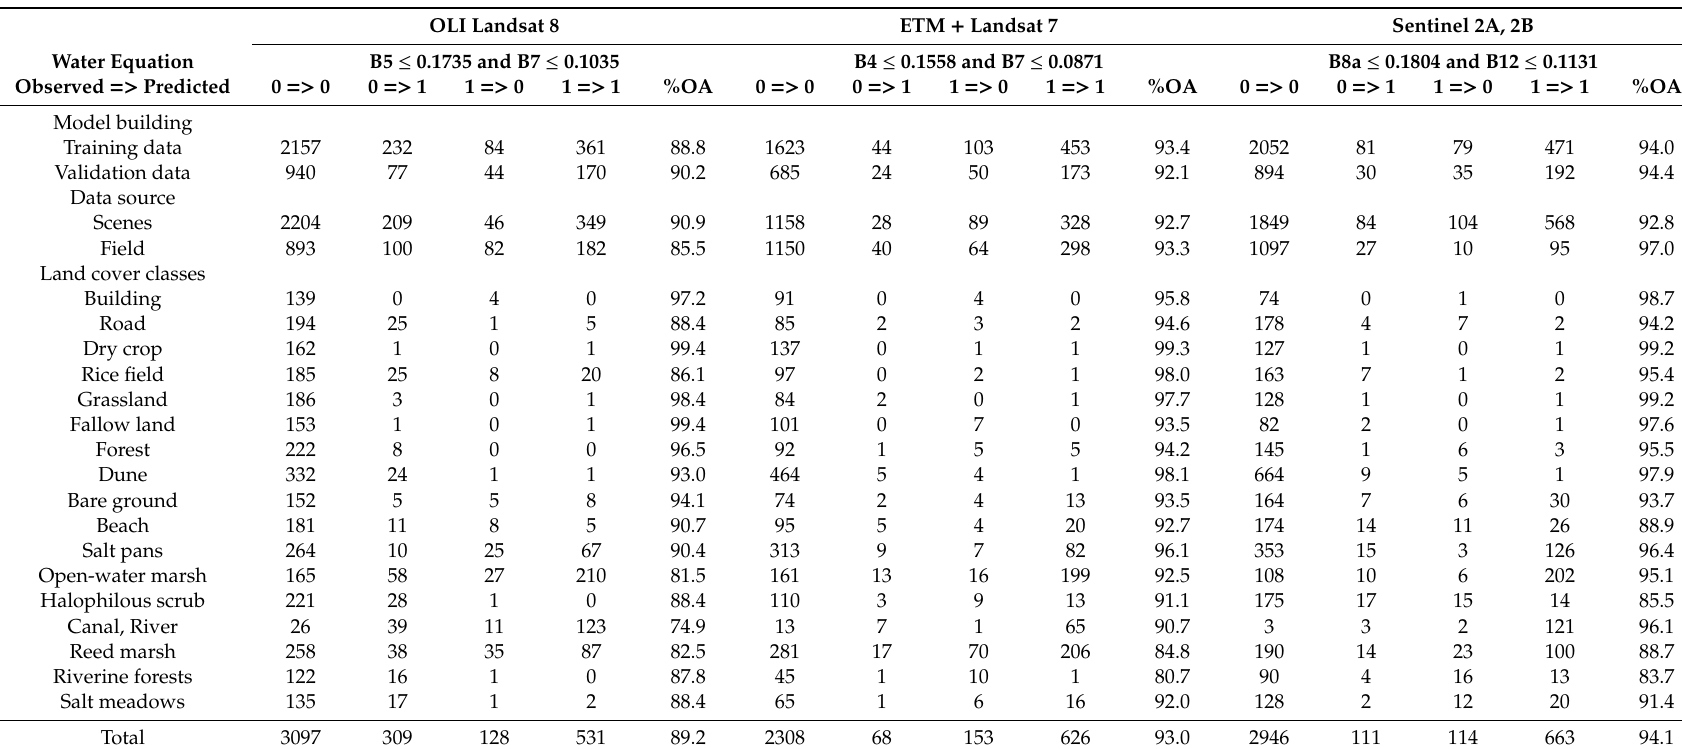
Table 3. Optimal classifiers for predicting water presence with error matrix and calculation of overall accuracy (%OA) according to land cover types for each satellite. OLI Landsat